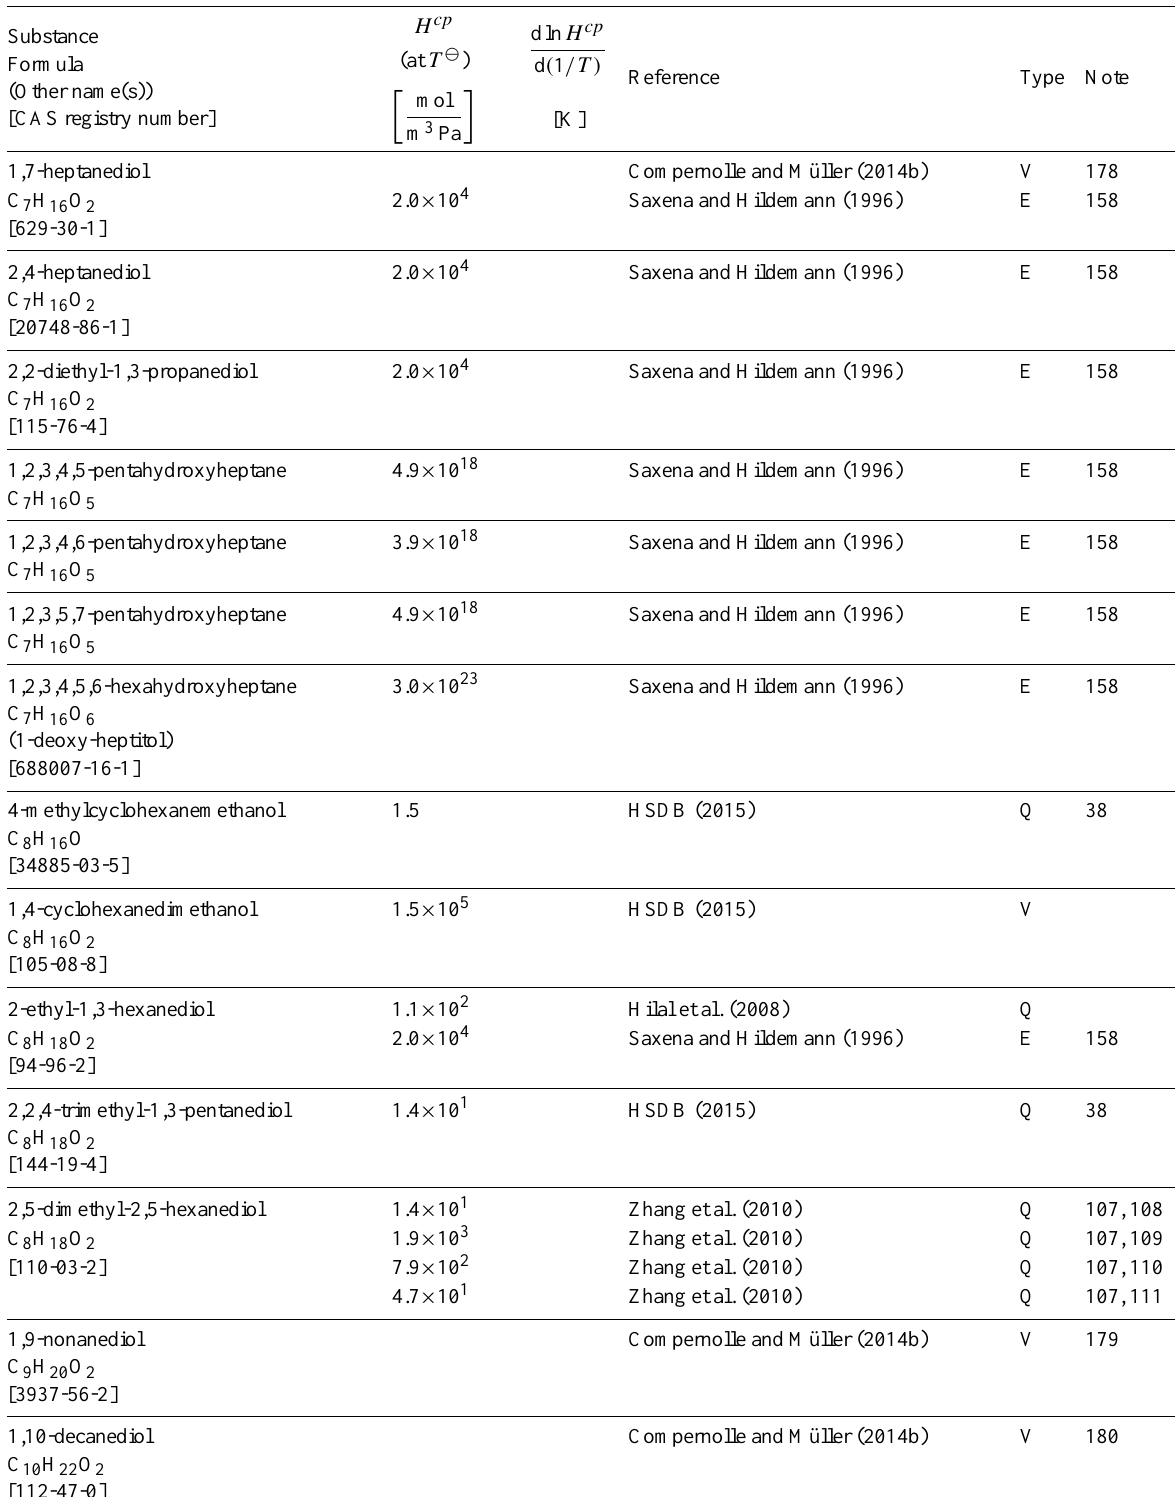
Table 6: Henry’s law constants for water as solvent